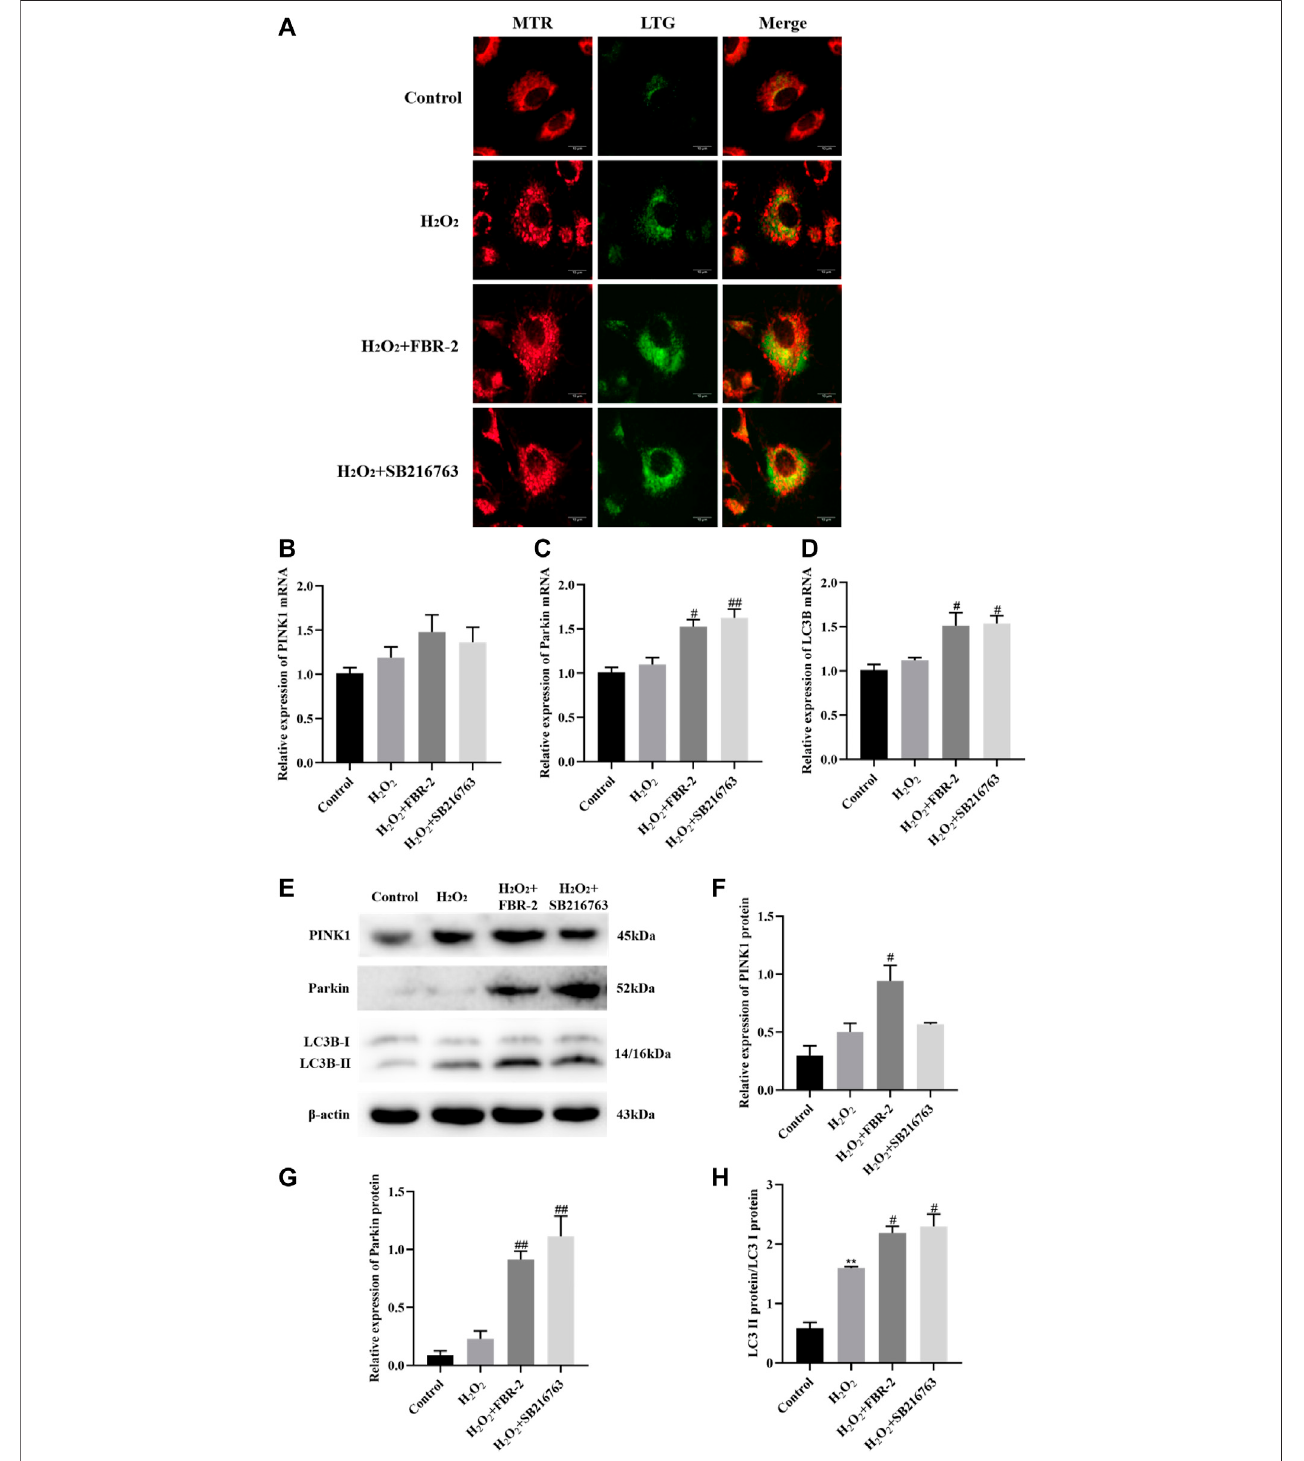
FIGURE 7 | FBR-2 promotes mitophagy. (A) Fluorescence colocalization between mitochondria (MTR) and lysosomes (LTG). (B) PINK1 mRNA levels ( n = 6). (C) ParkinmRNAlevels( n =6). (D) LC3B mRNAlevels( n =6). (E) TheblotsofPINK1,Parkin,LC3Band β -actin. (F) PINK1protein levels ( n =3). (G) Parkinprotein levels( n = 3). (H) The ratio of LC3B II/I ( n = 3). ** p < 0.01, compared with the control group; # p < 0.05 and ## p < 0.01, compared with the H 2 O 2 group.